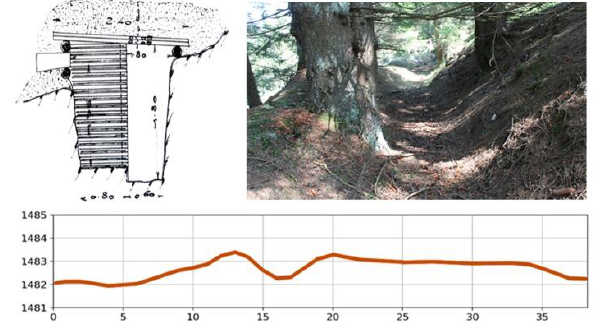
Figure 19 . Territorial sections obtained in QGIS environment in correspondence of the original tracks of the trenches.